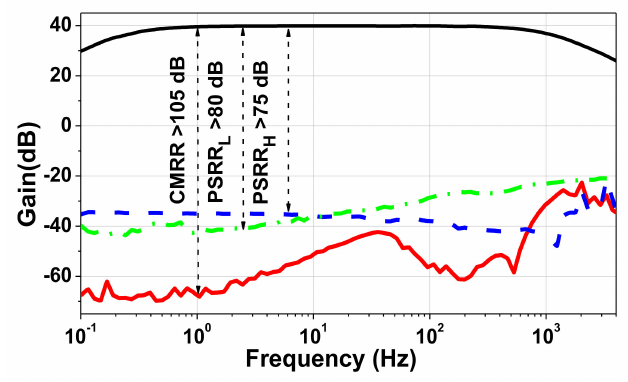
Figure 14. Measured CMRR and power supply rejection ratio (PSRR) as a function of frequency.